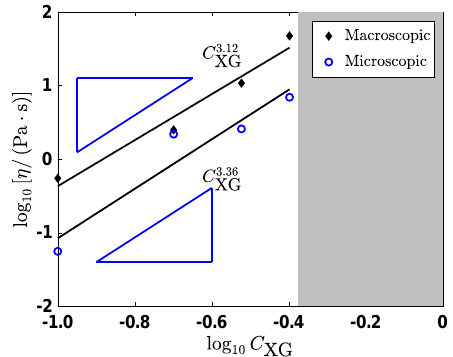
Figure 10: Viscosity of ASM as a function of different concentrations of XG, C XG ∈ { 0.1, 0.2, 0.3, 0.4 } % . The gray area shows the con- centration of XG that cannot be used to calculate the viscosity be- cause the particles are permanently captured in elastic cages. The microscopic viscosities were obtained from the long-time diffusive region. The macroscopic viscosity was found using the zero-shear